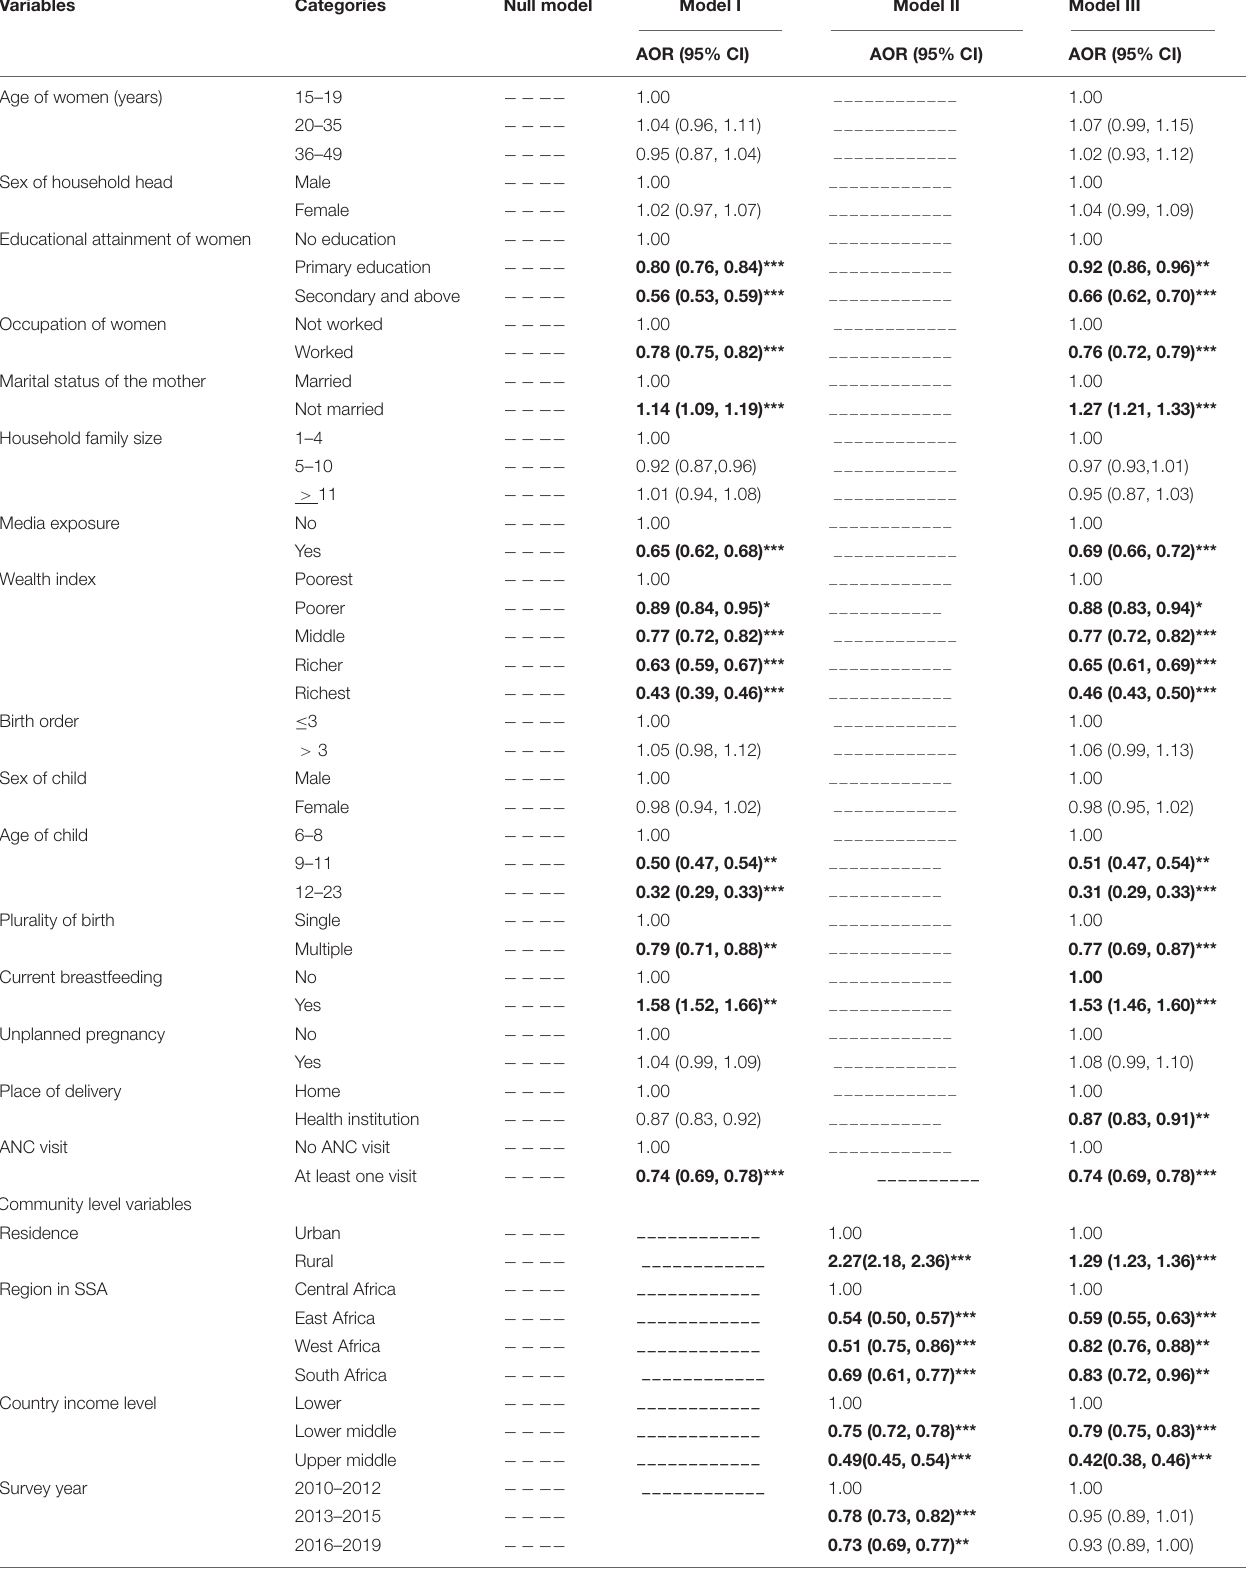
TABLE 6 | Multilevel analysis of factors associated with inappropriate dietary diversity intake among children aged 6–23 months in sub-Saharan Africa: based on 2010 to 2020